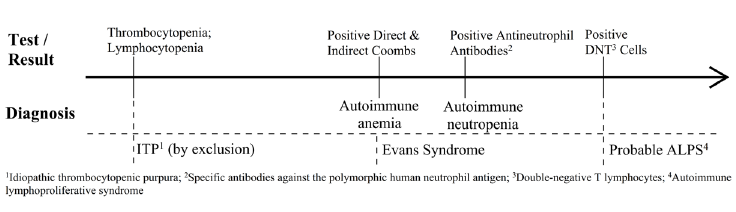
Figure 1. Pertinent Positive Laboratory Test Results Showing the Progression of Likely Diagnoses in a Patient with Probable ALPS